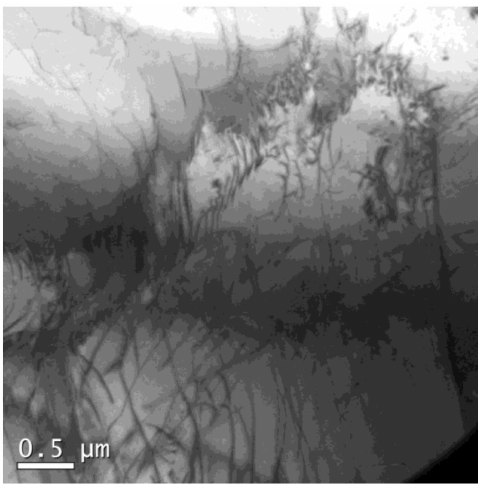
Figure 12. Dislocation morphology in subgrain in 18Mn18Cr0.6N steel compressed at a cooling rate of 0.025 Ks − 1 to a strain of 0.8.